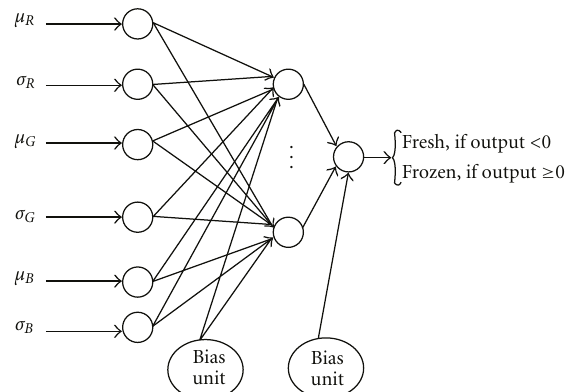
Figure 6: Process neural network (ProcNN) for fresh and pureed samples.